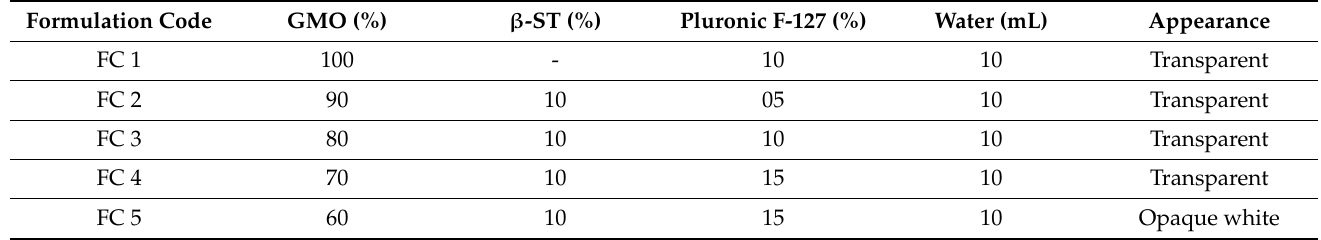
Table 1. The composition of β -ST-CUBs.